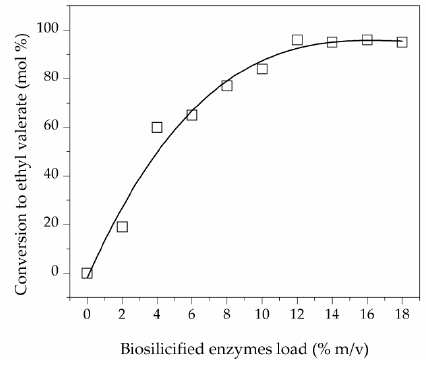
Figure 3. Effect of amount of biosilicified enzyme on the conversion of valeric acid to ethyl valerate (study conditions: molar ratio 1:2 of valeric acid to EtOH, 1000 rpm, 40 °C, 2 h in CH batch reactor).